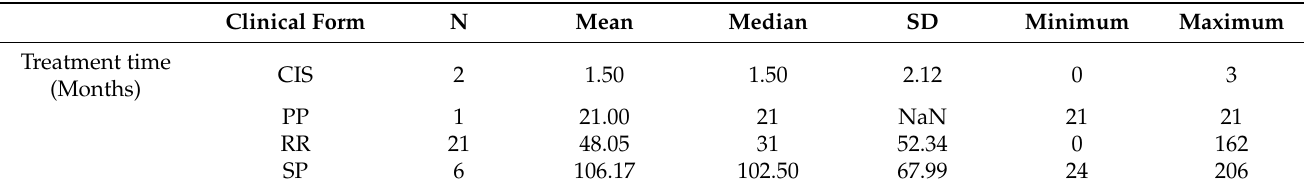
Table 2. Distribution of patients by clinical forms with treatment time.